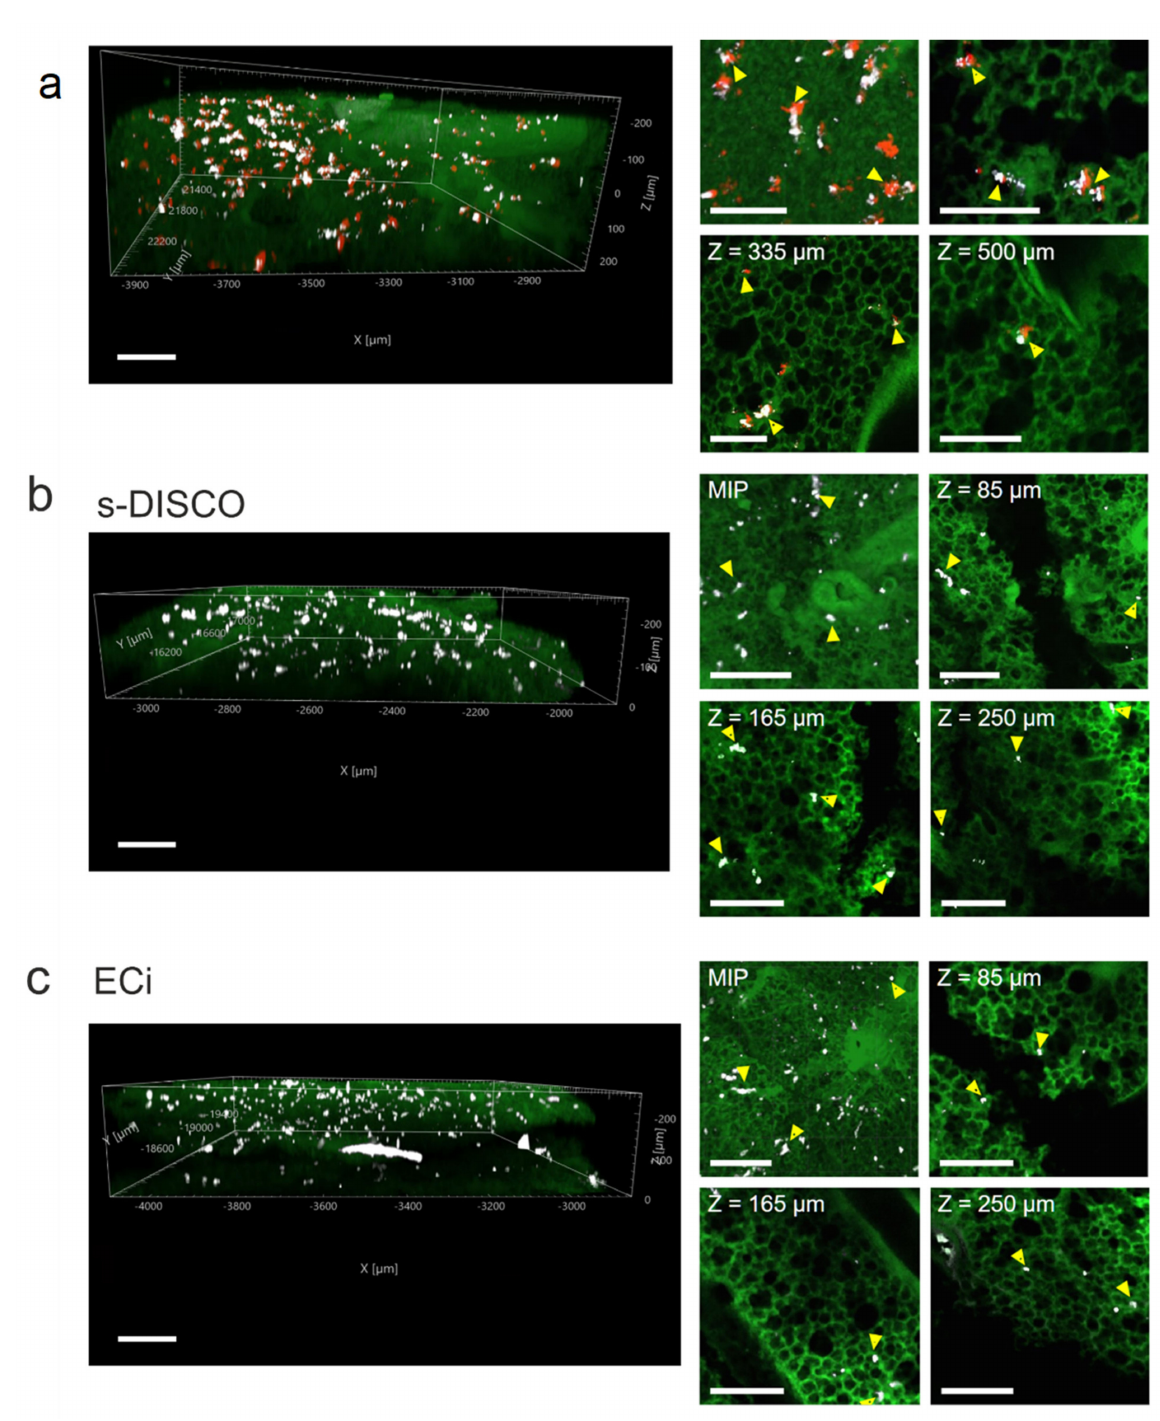
Figure 4. Preservation of immunofluorescence after optical tissue clearing. The human mitochondria antibody (white) was used to stain the tdTomato hUC-MSCs (red) in 500 µ m lung sections followed by clearing with either CUBIC, s-DISCO or ECi. The antibody penetrated the entire depth in all samples. ( a ) Three-dimensional z-stack of a CUBIC-cleared lung section (left). Maximum-intensity projection and single slices at different sample depths (right). ( b ) Three-dimensional z-stack of an s-DISCO-cleared lung section (left). MIP and single slices at different sample depths (right). ( c ) Three- dimensional z-stack of an ECi-cleared lung section (left), MIP and single slices at different sample depths (right). hUC-MSCs are indicated by arrowheads. Scale bar = 200 µ m (left), 150 µ m